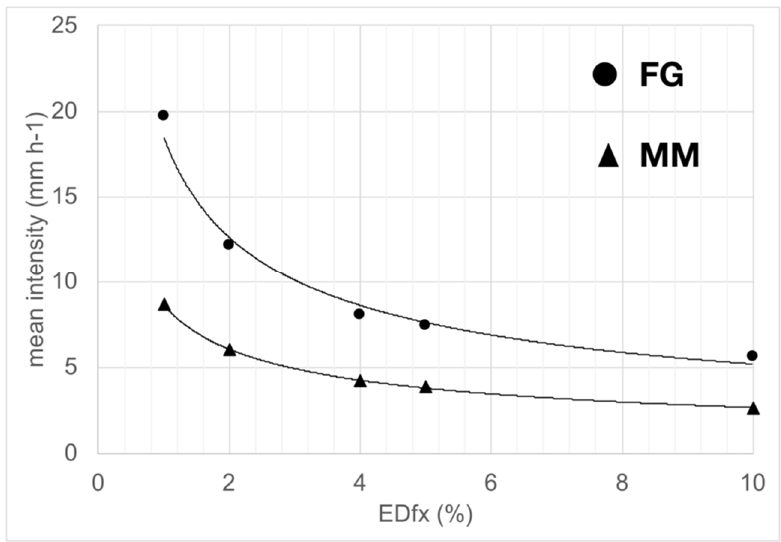
Figure 4. Variation of mean rainfall intensity expressed by the EDfx index for values from 1% of event duration to 10% of event duration. The lines drawn through the data points are the regression models as described in the text (Equations (1) and (2)).